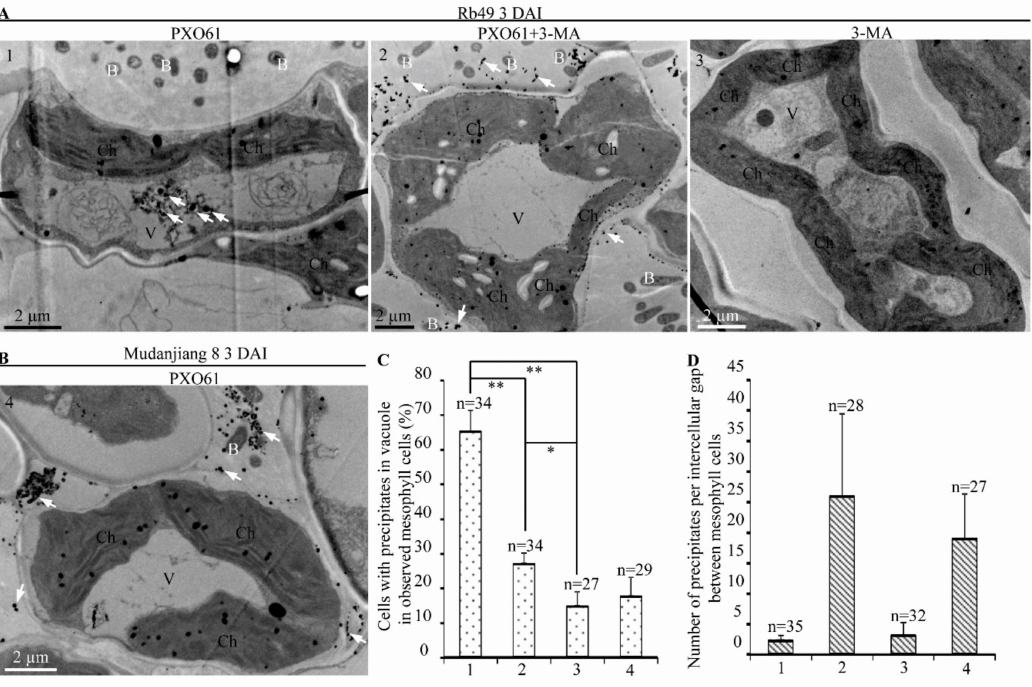
Figure 7. Calcium ion distribution in mesophyll cells a ff ected by autophagy inhibitor 3-methyladenine at 3 DAI. B, Xoo bacterium; Ch, chloroplast; V, vacuole; white arrow, calcium pyroantimonate precipitates (high electron-density). ( A ) 3-methyladenine (3-MA) changed the distribution of calcium pyroantimonate precipitates in Rb49 plants infiltrated with Xoo strain PXO61 in H 2 O solution, in 3-MA solution, and with only 3-MA solution. ( B ) Calcium precipitates were mainly localized in the intercellular gaps of mesophyll cells in Mudanjiang 8 infiltrated with PXO61 in H 2 O solution. ( C , D ) Percentage of cells with calcium precipitates in vacuole in all the observed mesophyll cells and number of calcium precipitates per intercellular gap between mesophyll cells. Data represent mean (27–34 mesophyll cells from 3 plant leaves and 27–35 precipitates distributed in intercellular gaps between mesophyll cells from 3 plant leaves) + standard deviation. n, the number of all the observed cells and the number of all the observed intercellular gaps. Double asterisks (**) indicate the significant di ff erences between PXO61 infiltration in H 2 O solution and PXO61infiltration in 3-MA solution, between PXO61infiltration in H 2 O solution and only 3-MA solution infiltration at p < 0.01 in Rb49 plants. Single asterisk (*) indicates the significant di ff erence between PXO61 infiltration in 3-MA solution and only 3-MA solution infiltration at p < 0.05 in Rb49 plants. The 1, 2, 3, and 4 represent Rb49 plant infiltrated by PXO61 in H 2 O solution, that by PXO61 in 3-MA solution, that infiltrated only by 3-MA solution, and Mudanjiang 8 plant infiltrated by PXO61 in H 2 O solution,